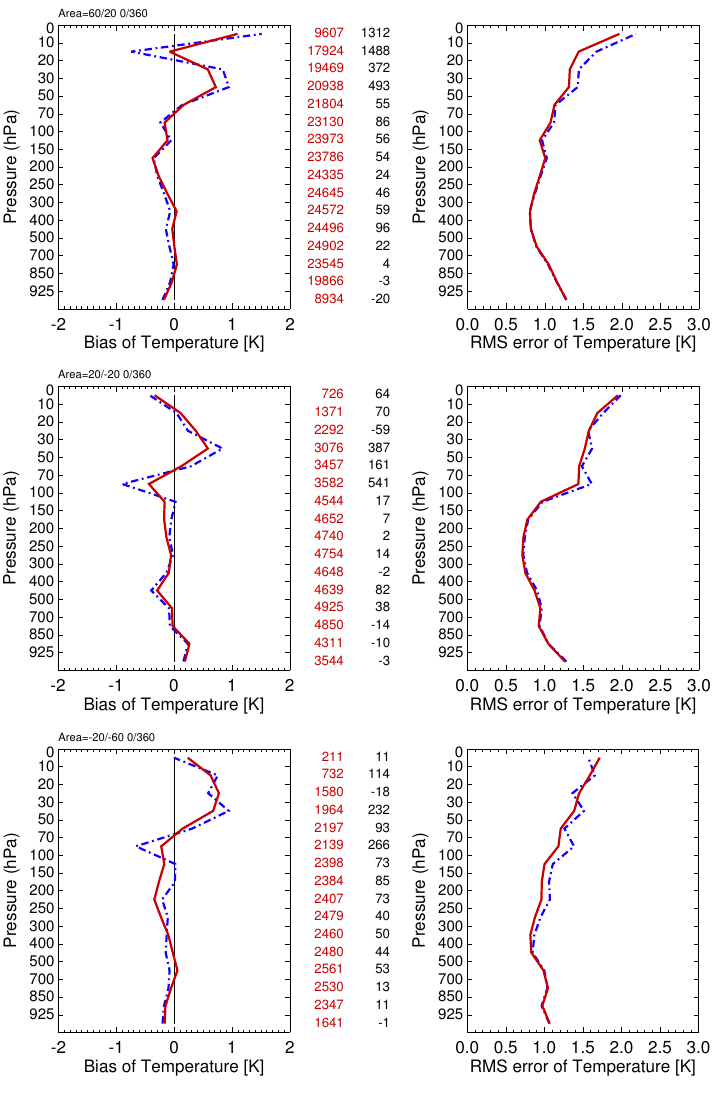
Fig. 2. The mean departure (left) and RMS difference (right) of radiosonde temperature observations to 3-h forecasts for the reference run (dash-dotted blue line) and the GPSRO experiment (continuous red line). The rows show the comparisons for observations in the latitude bands 20 ◦ N–60 ◦ N, 20 ◦ S–20 ◦ N, and 60 ◦ S–20 ◦ S (from top to bottom). The central columns display the number of samples used in the experiment (red) and the difference of experiment to reference